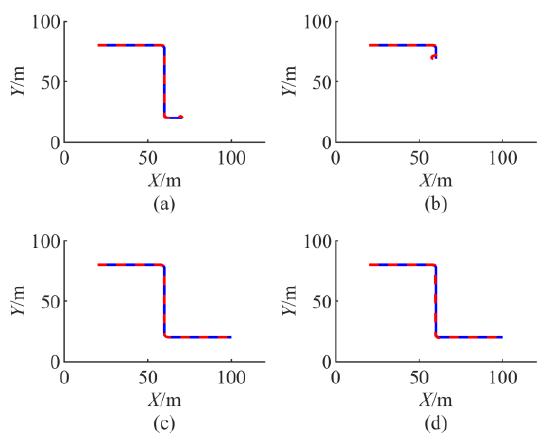
Figure 13. The trajectory when velocity is 4 m / s. The red line is the trajectory. The blue line is the reference path. ( a ) LMPC. ( b ) LEMPC. ( c ) NMPC. ( d ) NEMPC.